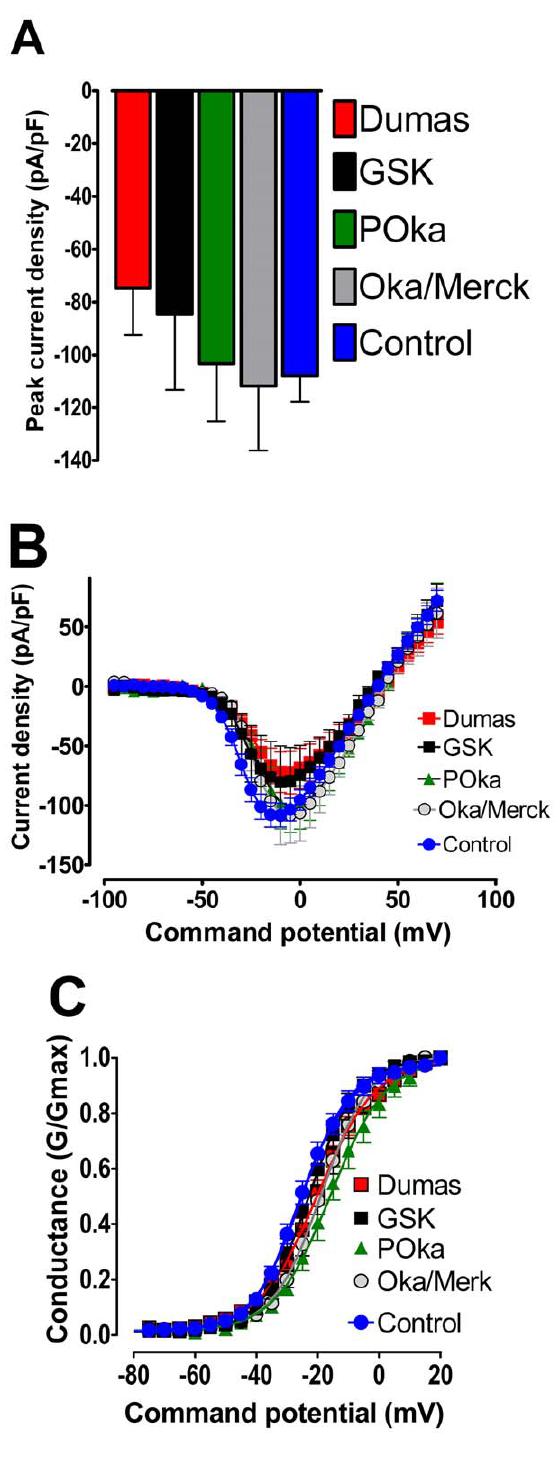
Figure 4. The lack of effect of VZV vaccine strains on sodium currents expressed in ND7/23 1.8 cells. (A) Comparison peak current density in cells exposed to Dumas vaccine strain (solid red bar), GSK vaccine strain (solid black bar), POka vaccine strain (solid green bar), Oka/Merk (solid grey bar) and control (solid blue bar) (p . 0.05, Analysis of Variance Newman-Keuls multiple comparison post hoc test. (B) conventional current density verses membrane potential plots for sodium currents from cells exposed to VZV vaccine strains: Dumas vaccine strain (red squares), GSK vaccine strain (black squares) POka vaccine strain (green triangles), Oka/Merk (grey